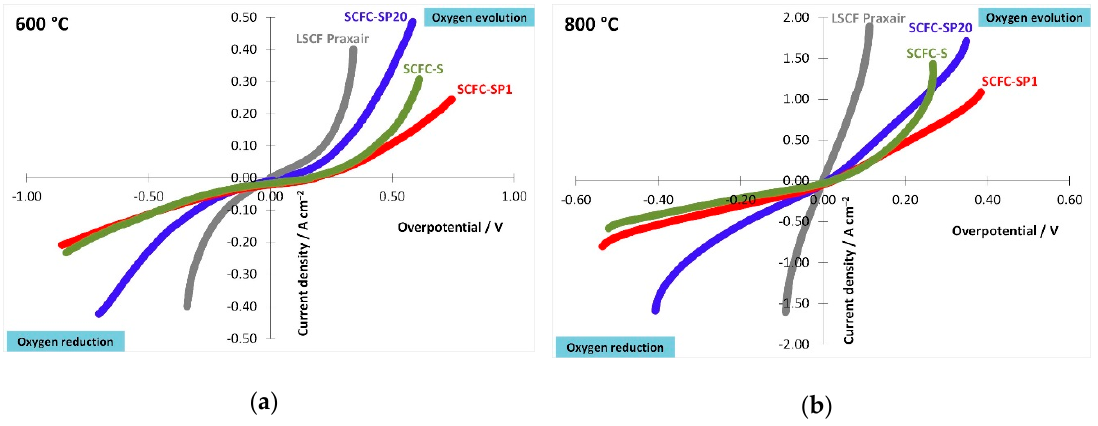
Figure 7. Overpotential measured at 600 ◦ C ( a ) and 800 ◦ C ( b ) for the three samples under study in comparison with a reference LSCF perovskite (Praxair).